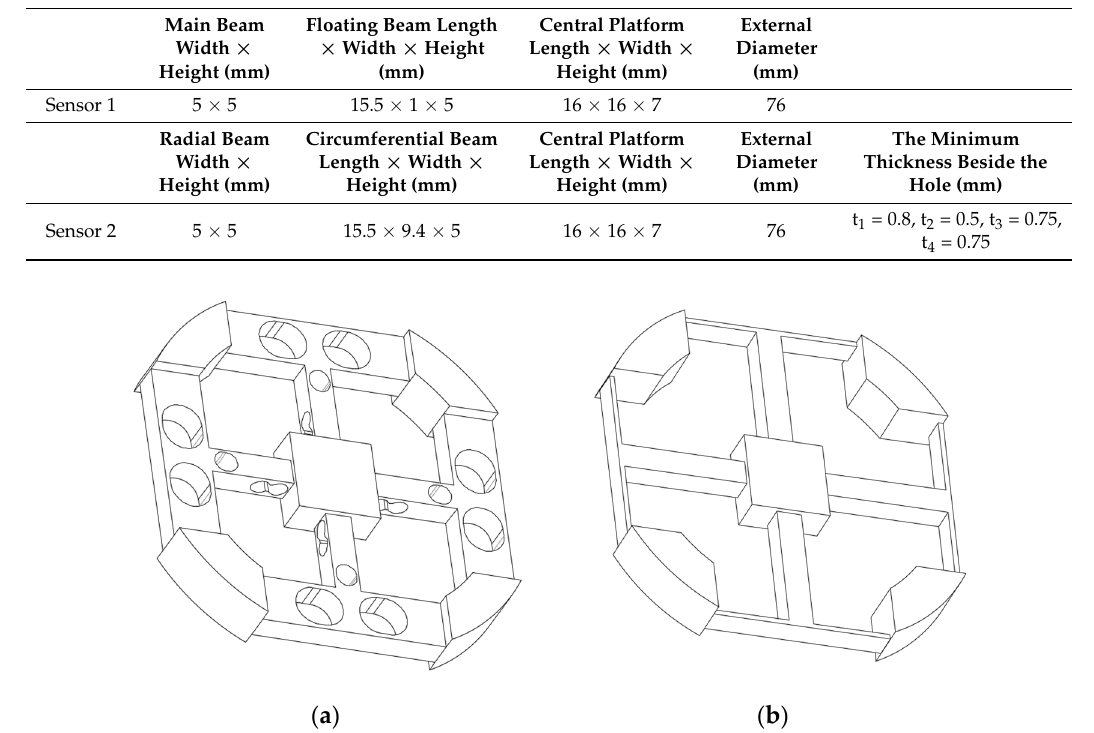
Figure 14. ( a ) Elastic body of Sensor 2. ( b ) Elastic body of Sensor 1.